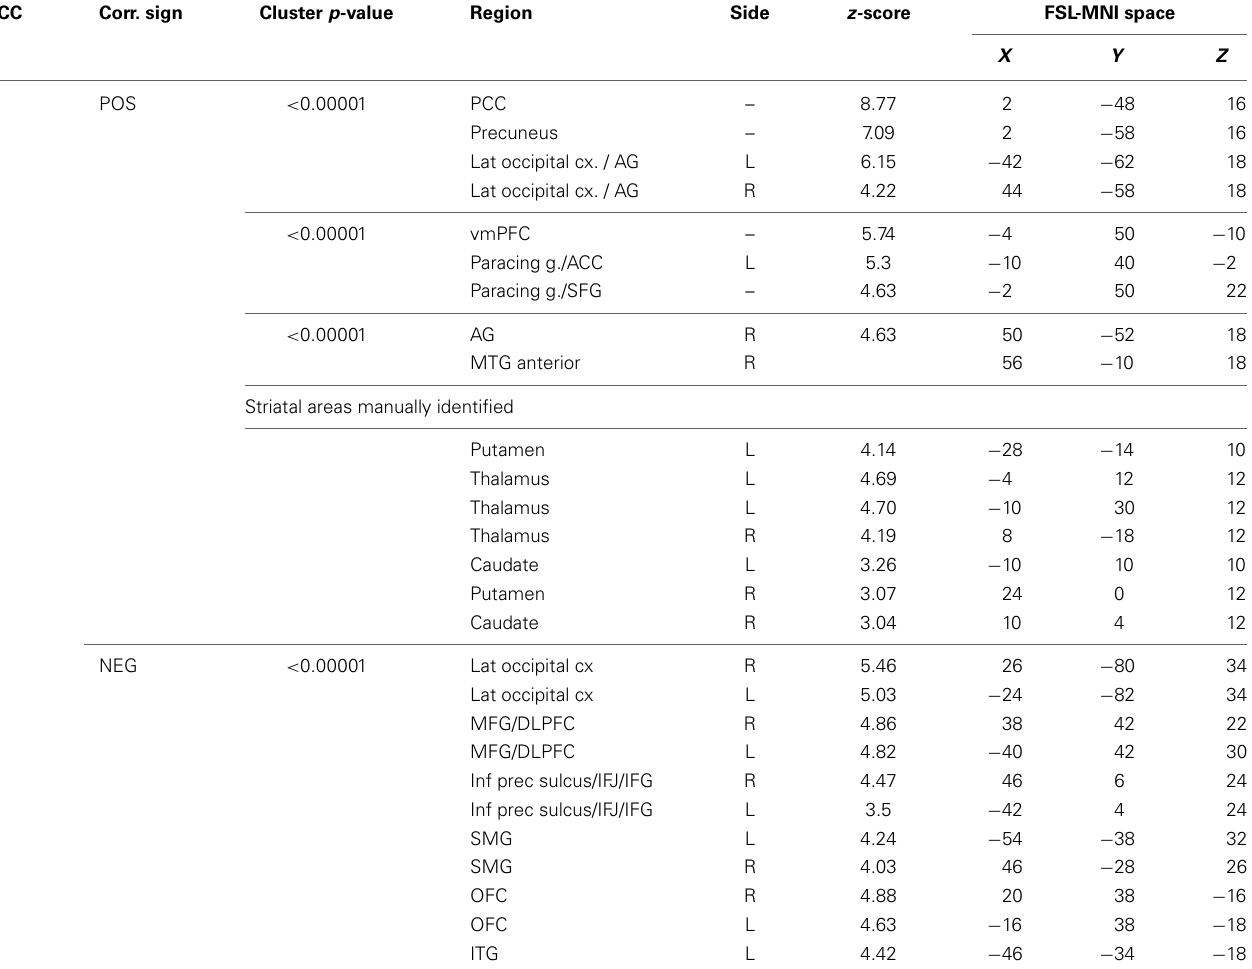
Table 2 | Group maps. PCC Corr.